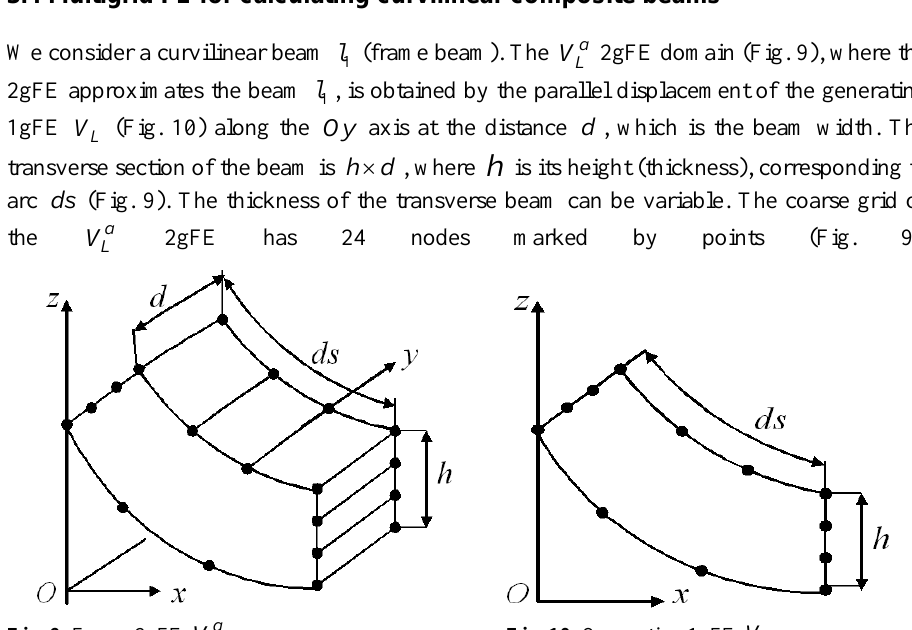
Fig. 9. Frame 2gFE Fig. 10. Generating 1gFE